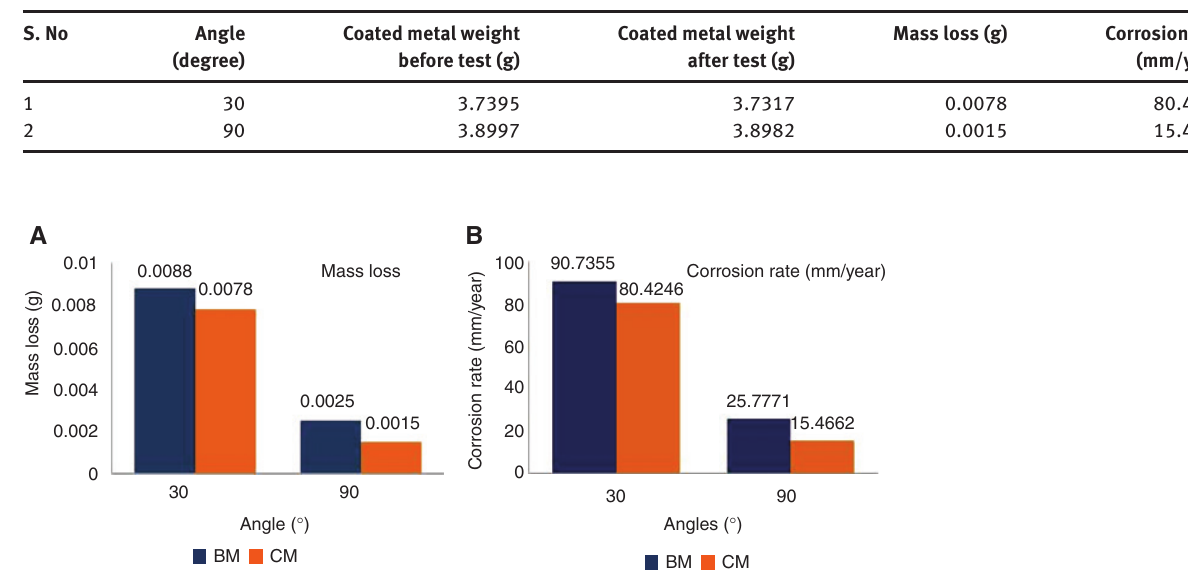
Figure 4, it is observed that in both charts the erosion and corrosion rate decreases at 90 ° , compared with 30 ° . For than the coated samples (Figure